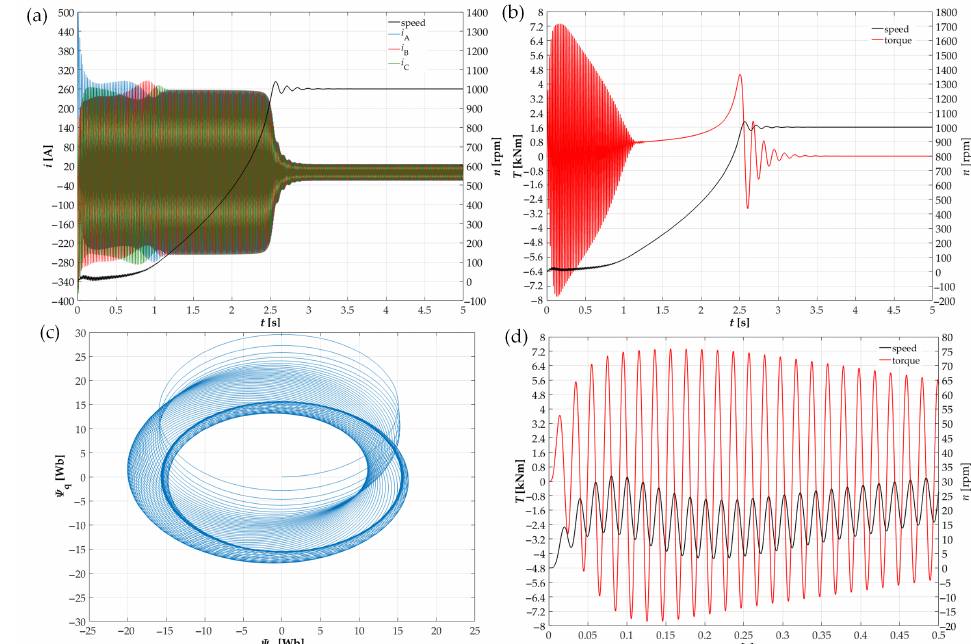
Figure 7. Waveforms of physical quantities for direct starting, with no voltage phase delay and load moment T o = 0 Nm: ( a ) time waveforms of the stator currents in three phases and rotational speed; ( b ) time waveform of the electromagnetic torque and rotational speed; ( c ) hodograph of the stator fluxes; ( d ) segment of the time waveform of the electromagnetic torque and rotational speed, in the first moment of start-up.